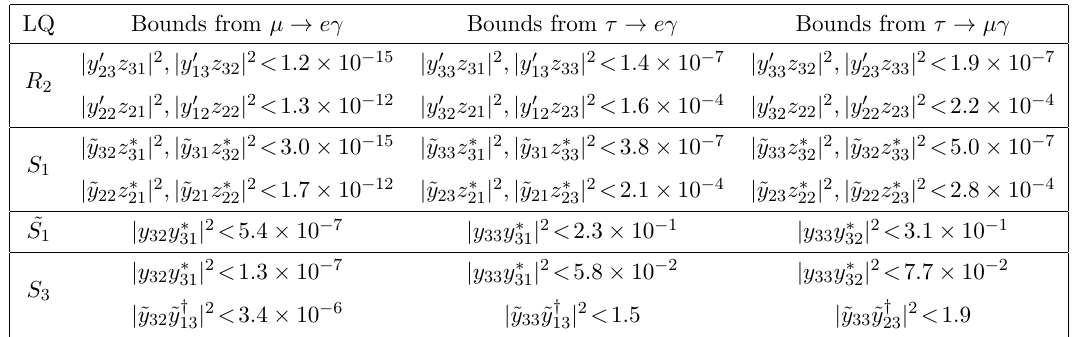
for heavier leptoquark masses. LQ